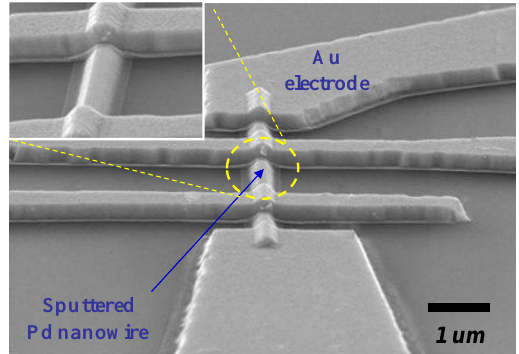
Figure 8. SEM image of a lithographically patterned Pd nanowire with t = 100 nm, w = 300 nm, and l = 10 m m. Four Ti/Au inner electrodes were patterned on the Pd nanowire. Data reproduced from Jeon et al .